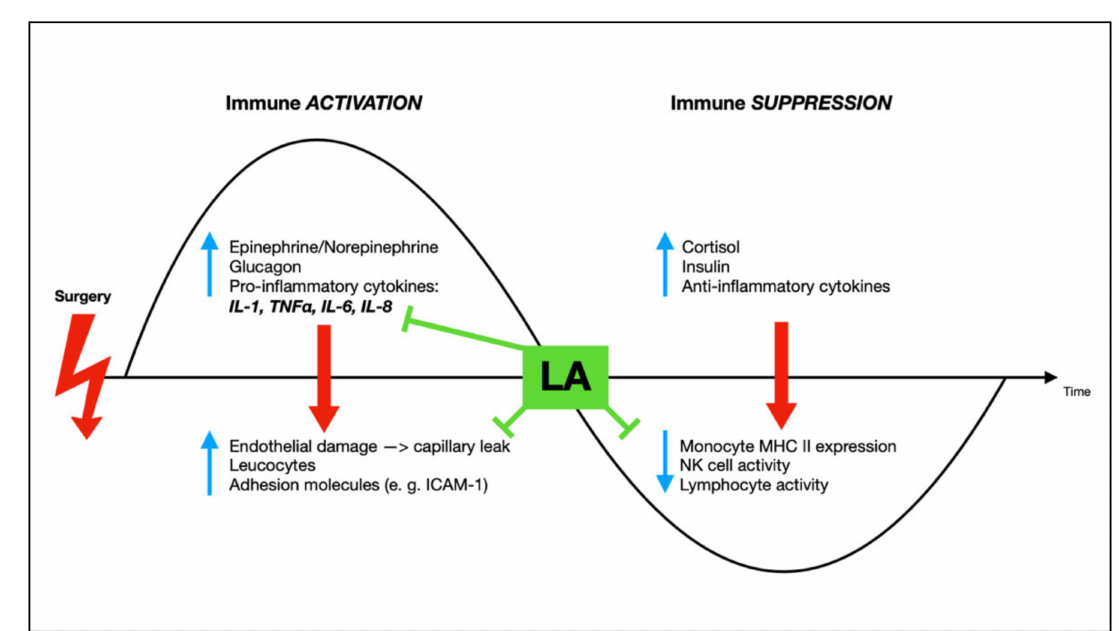
Figure 2. Schematic illustration of processes leading to perioperative inflammation and immune suppression (surgical stress response) and possible inhibition by local anesthetics (shown as ⊥ ). LA = local anesthetics; IL = interleukin; TNF α = tumor necrosis factor α ; ICAM-1 = intercellular adhesion molecule 1; MHC = major histocompatability complex; NK cell = natural killer cell. Modified after